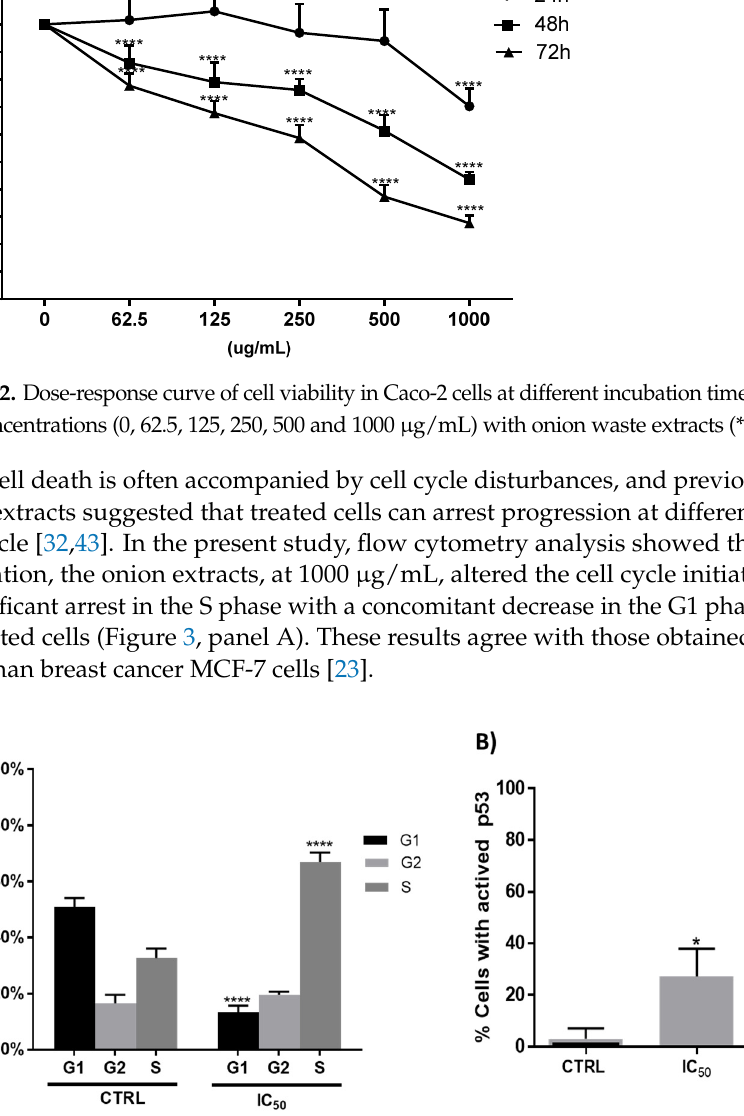
Figure 3. ( A ). Relative cell cycle phases in Caco-2 cells after 48 h incubation in absence (CTRL) or presence (IC 50 = 1000 µg/mL) of onion extracts**** p < 0.0001. ( B ). Percentage of Caco-2 cells with presence of active p53 after 48 h incubation with onion extract at IC 50 (1000 µg/mL). * p < 0.05 vs. CTRL (untreated cells).